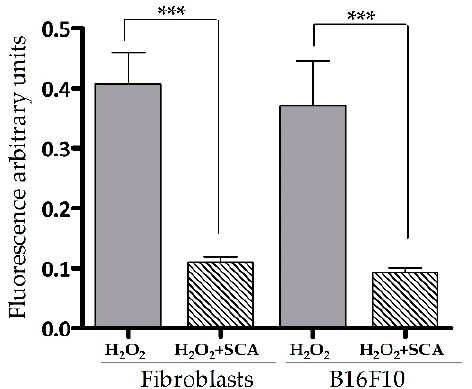
Figure 2. SCA ® treatment reduced ROS accumulation in senescent cells exposed to H 2 O 2 . Intracellu- lar ROS levels. Arbitrary fluorescence units of DCFH-DA probe showing the presence of intracellu- lar ROS in senescent fibroblasts and B16-F10 cells (H 2 O 2 ) and senescent fibroblasts and B16 cells treated with SCA ® (H 2 O 2 + SCA) (*** p < 0.0001).